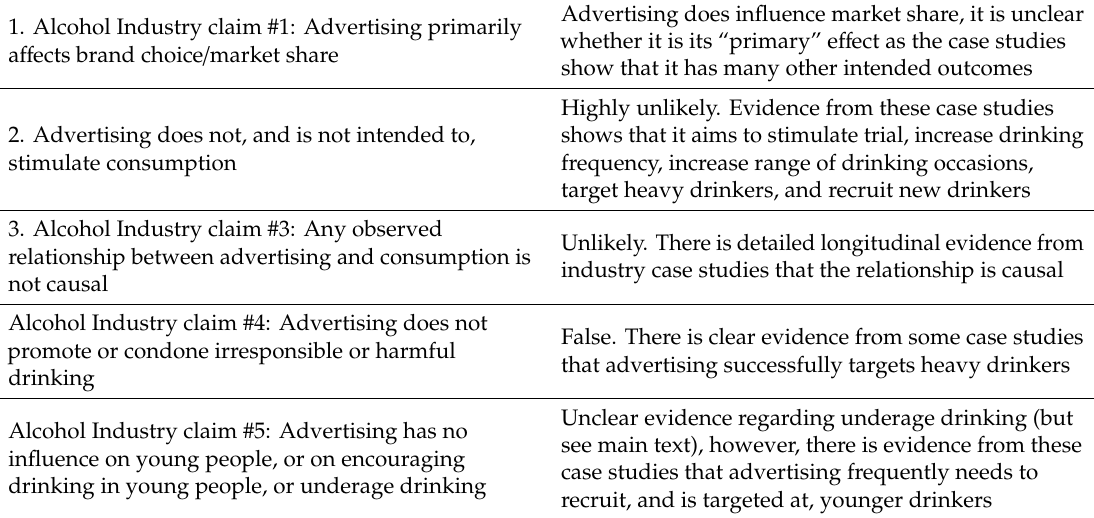
Table 4. Summary of findings regarding five key industry claims about advertising, based on advertising industry